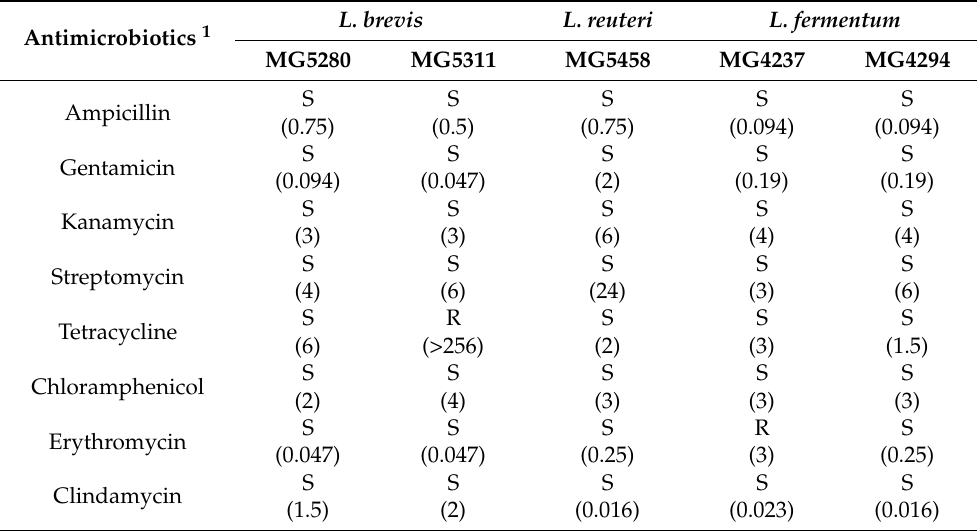
1 Susceptible (S) and resistant (R) strains according to the microbiology cutoff values from the EFSA guideline [18]. The minimum inhibitory concentrations are indicated in parentheses ( µ g/mL).